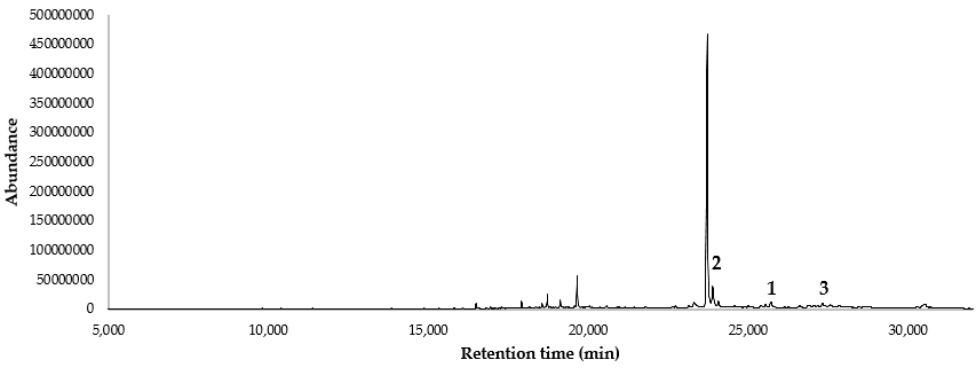
Figure 1. Selective gas chromatography–mass spectrometry (GC-MS) analysis (single ion monitoring, SIM) for Sipaucins ions in the ethyl acetate extract of Siparuna echinata. 1 , possible peak of Sipaucin A;